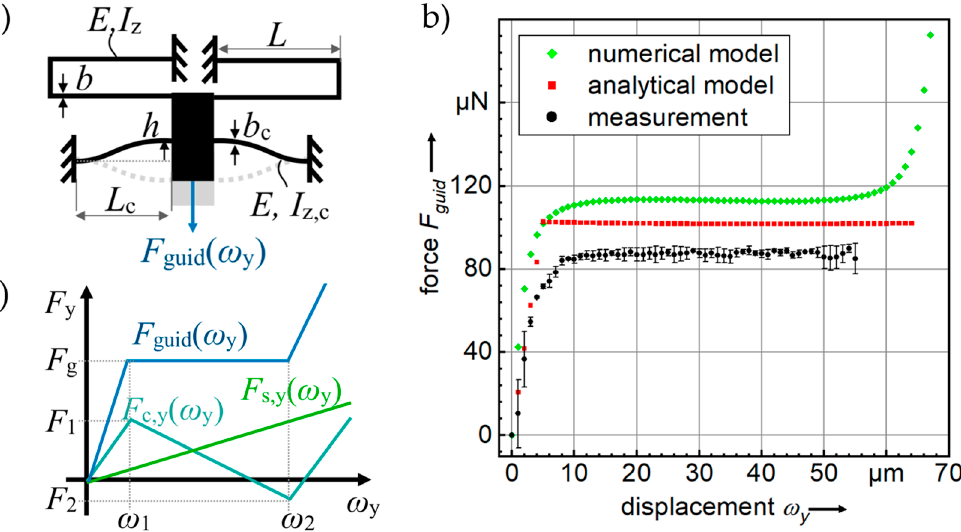
Figure 4. Constant-force mechanisms: ( a ) Setup, ( b ) the constant force characteristics resulting from a mechanical anti-spring with the negative spring rate F c,y , and ( c ) a spring with the linear spring rate F s,y combined with a spring with bi-stable spring rate F c,y resulting in a constant force F guid , as presented in [39]